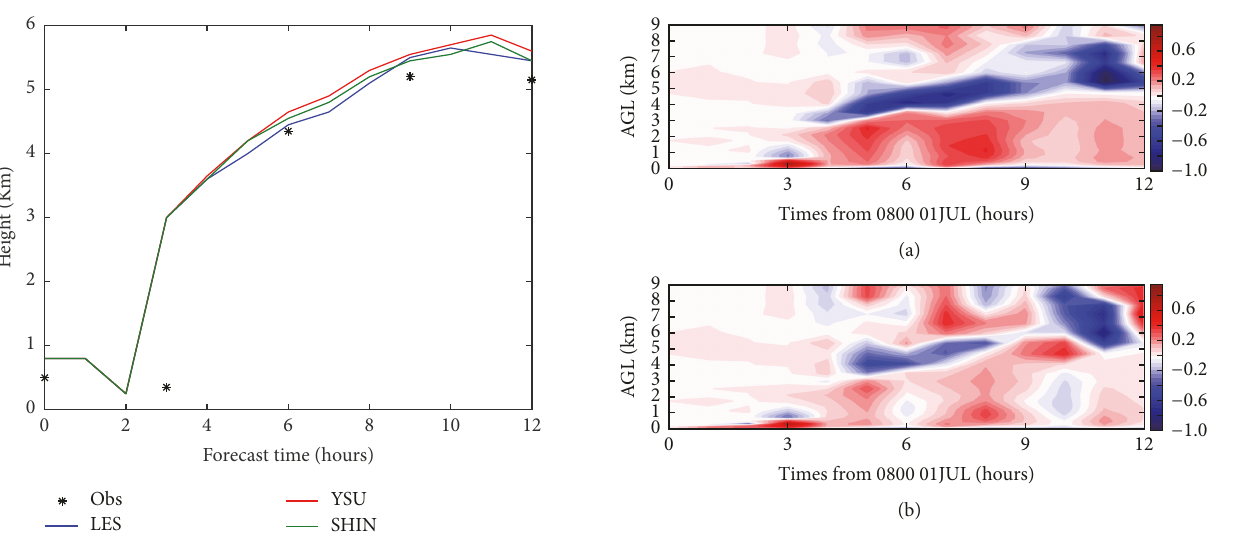
Figure 4: Time series of the PBL height (units: km) over Tazhong station from the GPS sounding (black), LES (green), YSU (red), and Shin-Hong (blue) experiments.